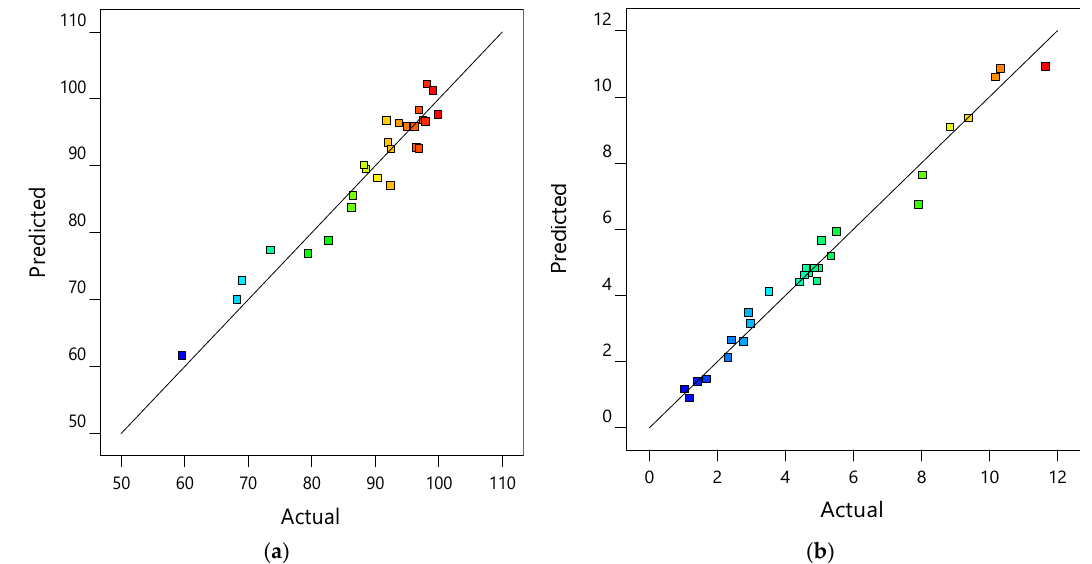
Figure 2. Actual versus predicted plots for ( a ) arsenic removal efficiency, ( b ) energy consumption per gram removal of arsenic.